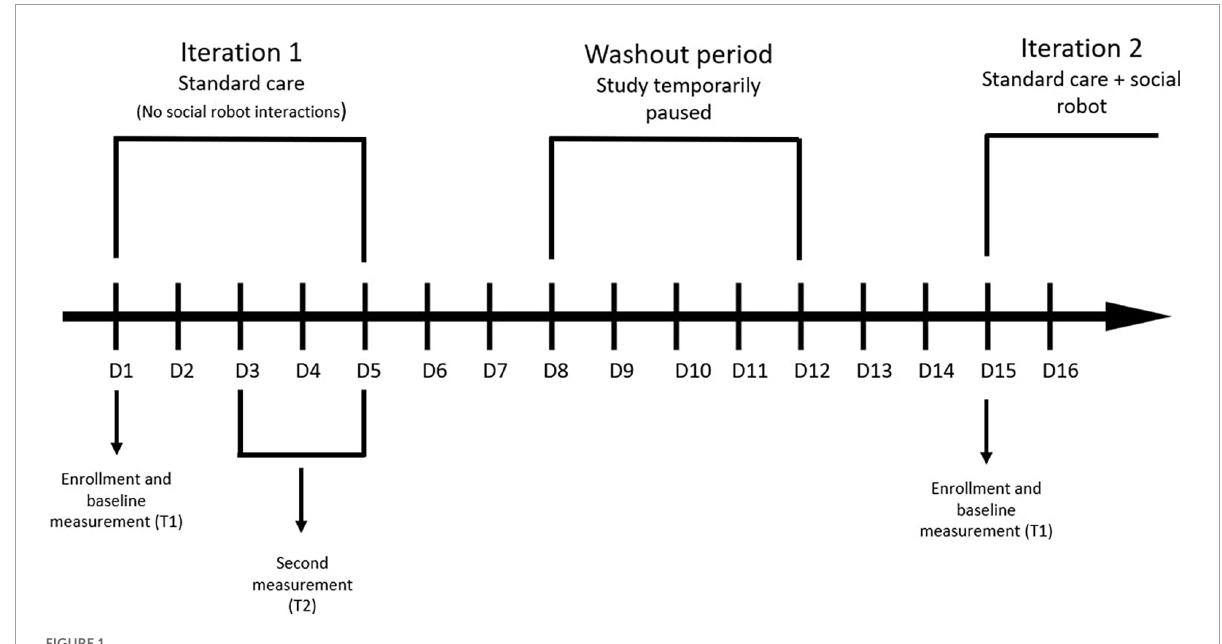
FIGURE1 Study design: